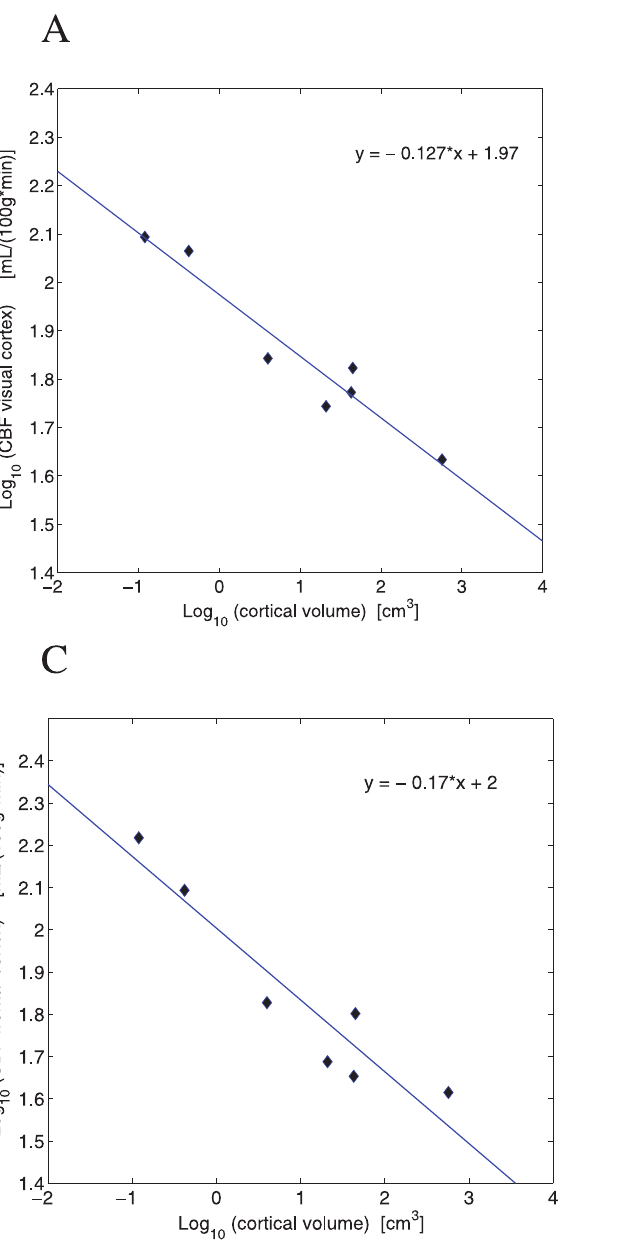
Figure 1. Scaling of cerebral blood flow CBF in the cortical gray matter. (A) Visual cortex: y ~{ 0 : 127 x z 1 : 98 ( R 2 ~ 0 : 93 , p v 0 : 001 ). 95 % confidence interval for the slope CI=( 2 0.168, 2 0.086). (B) Parietal cortex: y ~{ 0 : 150 x z 2 : 00 ( R 2 ~ 0 : 89 , p ~ 0 : 005 ), slope CI=( 2 0.222, 2 0.078). (C) Frontal cortex: y ~{ 0 : 170 x z 2 : 00 ( R 2 ~ 0 : 89 , p ~ 0 : 002 ), slope CI=( 2 0.239, 2 0.100). (D) Temporal cortex: y ~{ 0 : 191 x z 2 : 09 ( R 2 ~ 0 : 89 , p ~ 0 : 005 ),slopeCI=( 2 0.286, 2 0.096). doi:10.1371/journal.pone.0026709.g001 minimal value at R c ~ 3 { 3 : 5 m m (Table 1). Using the data in Table 1 taken from [35], we can approximate the denominator in Eq. (3) for this range of radiuses by a simple, explicit function of R c . The best fit is achieved with a logarithmic function, i.e. (Table 1). As a result, the effective blood viscosity takes a simple form: Þ { 2 = 3 : ð 4 Þ Cerebral blood flow CBF in the brain gray matter is defined as CBF ~ Q = V , where Q ~ N c Q c is the total capillary blood flow through all N c capillaries. Thus CBF is given by